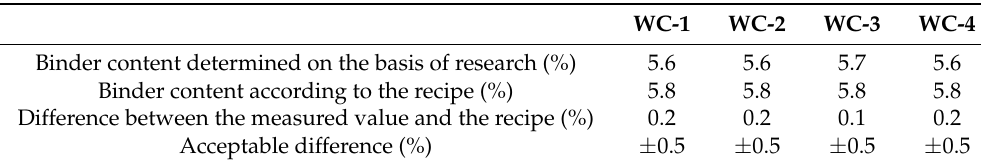
Table 7. Results pertaining to the soluble binder content.